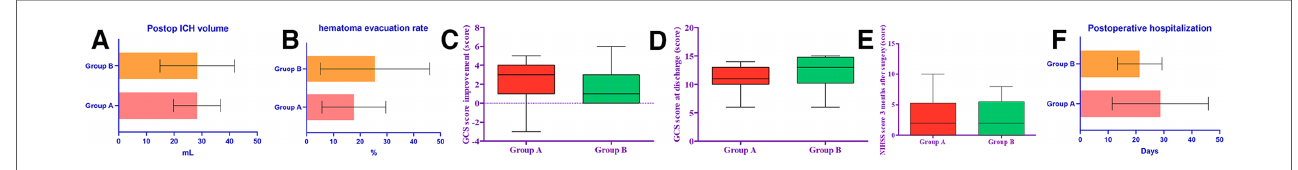
FIGURE 4 The histograms in the fi gure represent respectively the comparison of postoperative hematoma clearance rate, GCS score improvement, NIHSS score at 3- month postoperative follow-up, and postoperative hospital stay in groups A and B.